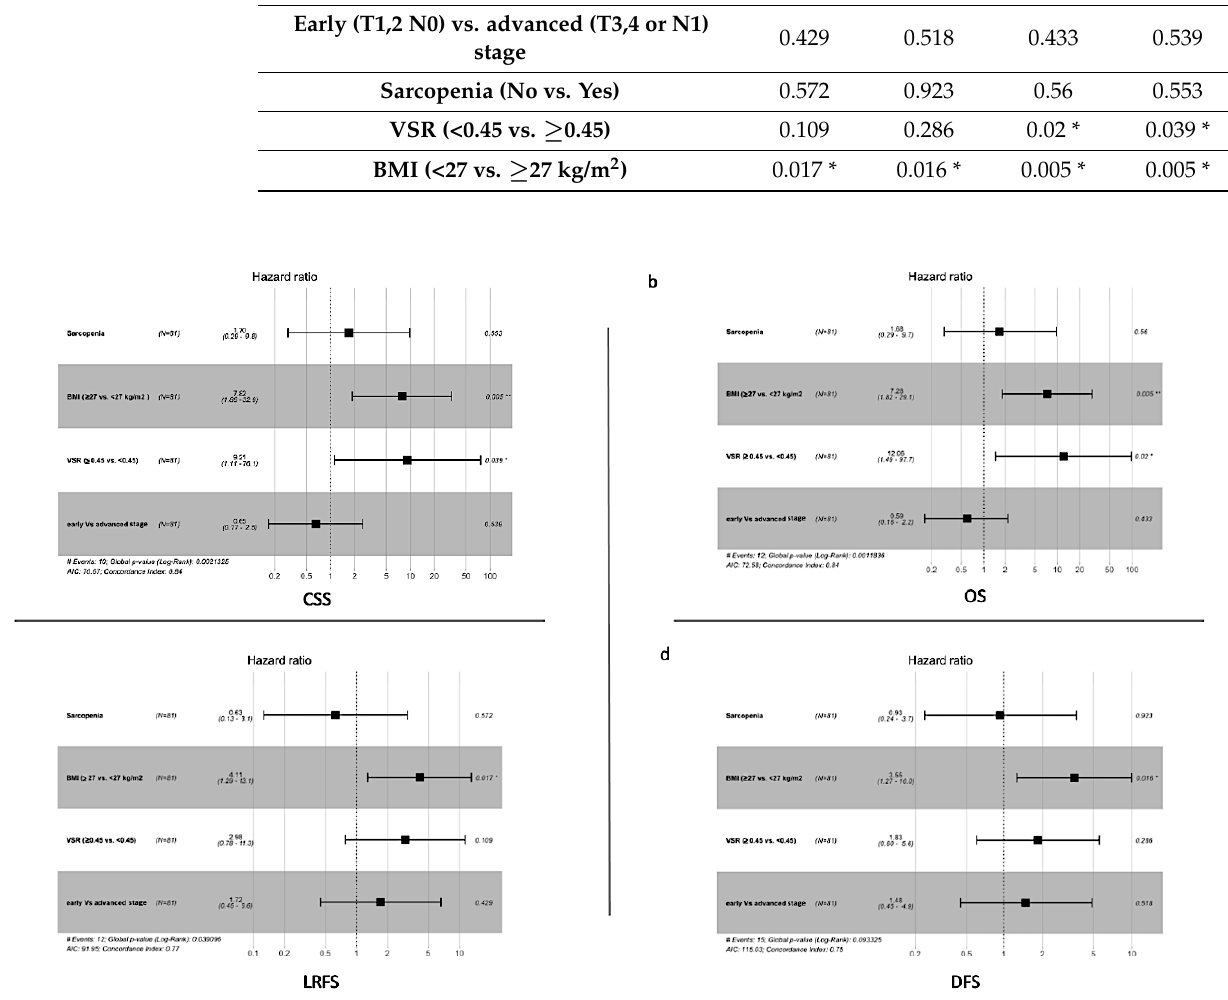
Figure 4. COX hazard regression analysis of Sarcopenia, BMI, VSR, and tumor stage for CSS ( a ), OS ( b ), LRFS ( c ), and DFS ( d ), showing the hazard ratio for each parameter, *: p value < 0.05, ** : p value ≤ 0.005 .